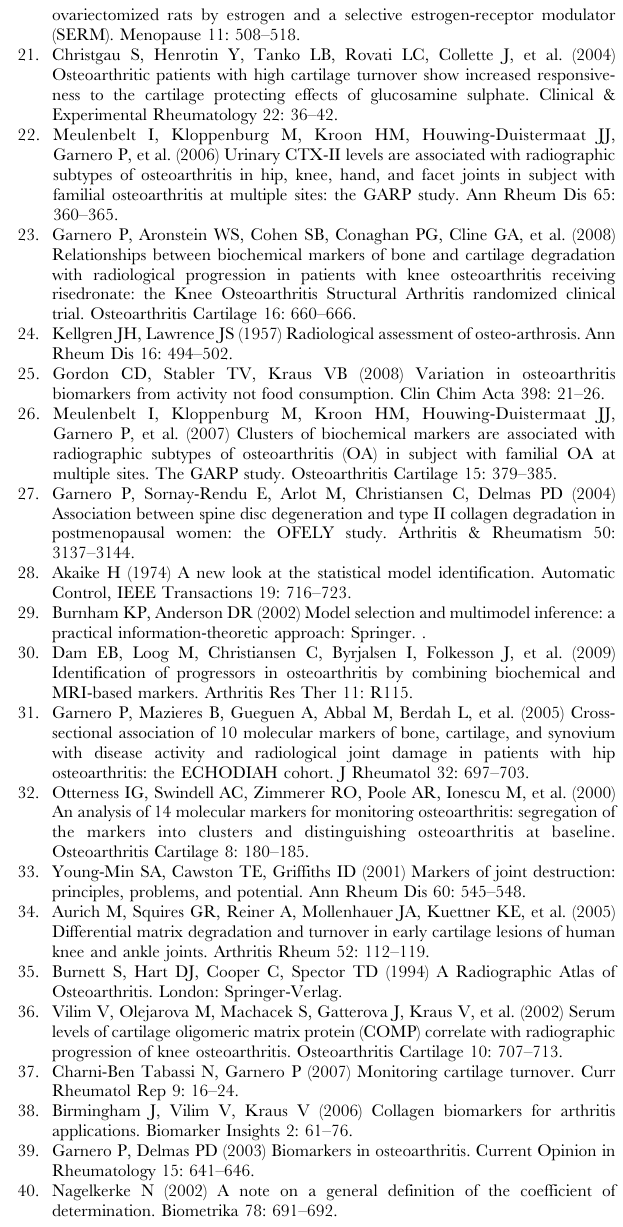
Figure S5 Linear coefficients of biomarker associations with radiographic features of OA (unadjusted). In this example, features are fit independently, so that correlations among features are not accounted for; the relationships between features and biomarkers in this analysis are complicated by these correlations (compare with Figure 3). Linear coefficients for each joint group and radiographic feature are shown. Figure S6 Example of complex interaction of OST and JSN on a biomarker concentration. Mean log uCTX2 concentrations